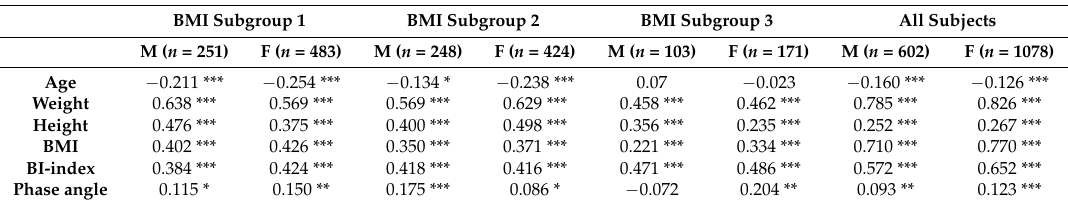
Table 3. Linear correlation between REE, individual characteristics and BIA parameters according to sex and